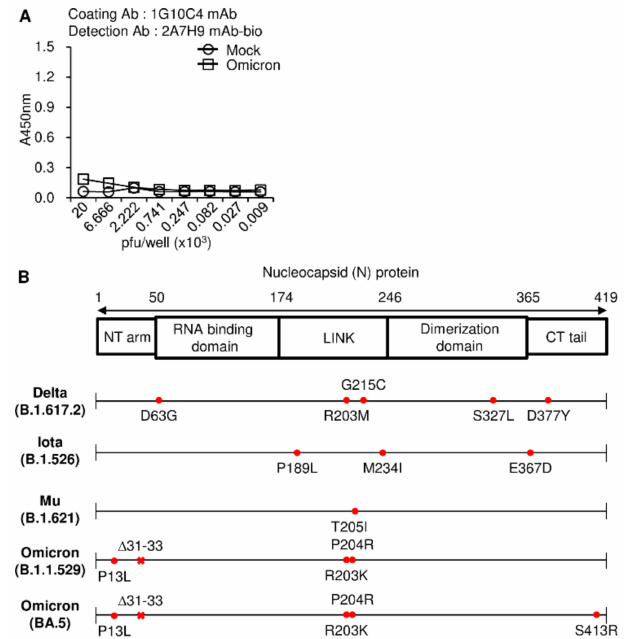
Figure 4. The 2A7H9 mAb does not detect the N protein in virus particles of the SARS-CoV-2 omicron variant. ( A ) Cell culture supernatants containing the SARS-CoV-2 omicron variant were lysed, and serially diluted virus lysates were added to 1G10C4 mAb-coated-immuno plates (100 ng/well) followed by the addition of biotinylated 2A7H9 mAb. Titration was performed after the addition of peroxidase-conjugated avidin (avidin-HRP). ( B ) Analysis of SARS-CoV-2 N protein sequences of SARS-CoV-2 variants. The numbers in the upper row denote the nucleocapsid (N) protein positions in the N gene. The lower rows indicate the mutation residues found in each variant compared to the SARS-CoV-2 S clade sequence. Deletions are indicated by ‘ ∆ ’. NT arm, N-terminal arm; CT tail, C-terminal tail.